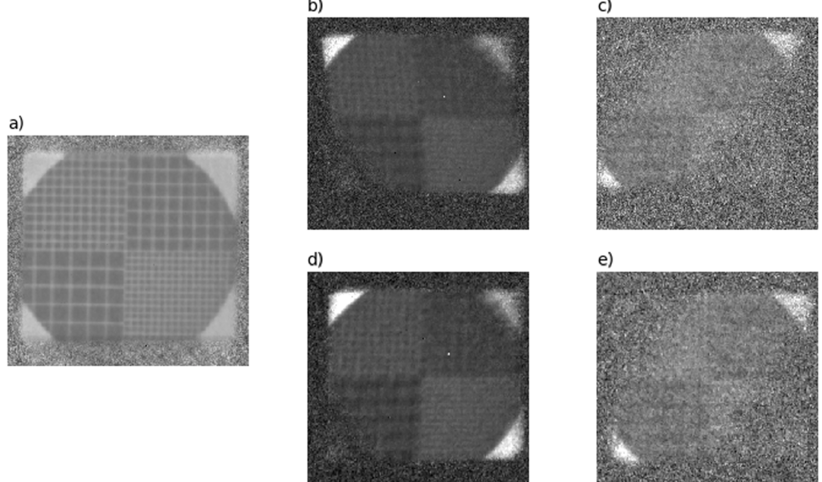
𝑛𝑜𝑟𝑚 𝑛𝑜𝑟𝑚 ; ( c ) K β image P norm ; ( d ) K α image after ; ( c ) 𝐾 𝛽 image 𝑃 𝐾 ; ( d ) 𝐾 𝛼 K α K β 𝛽 𝑝𝑟𝑜𝑗 . K β 𝛽